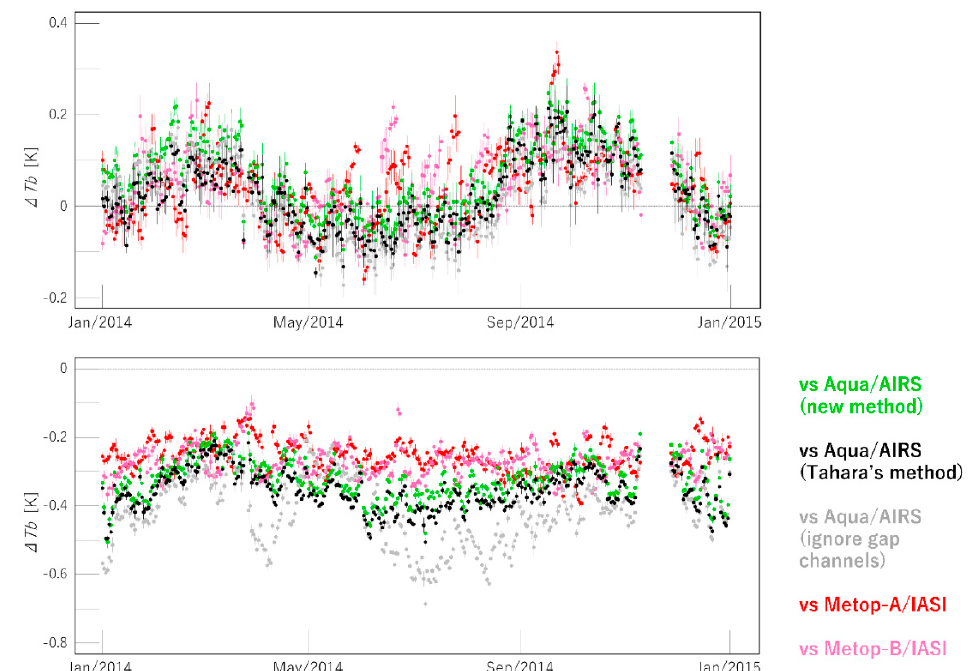
Figure 12. Bias of original MTSAT-2 / IMAGER IR (top) and WV (bottom) channel radiance against Aqua / AIRS or Metop-A,B / IASI at standard radiance. Note that during the gap that is seen in November, MTSAT-1R was the operational satellite.